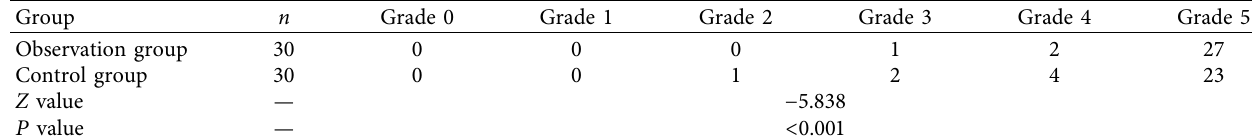
Table 2: Comparison of the recovery of lower-limb muscle strength between the two groups.